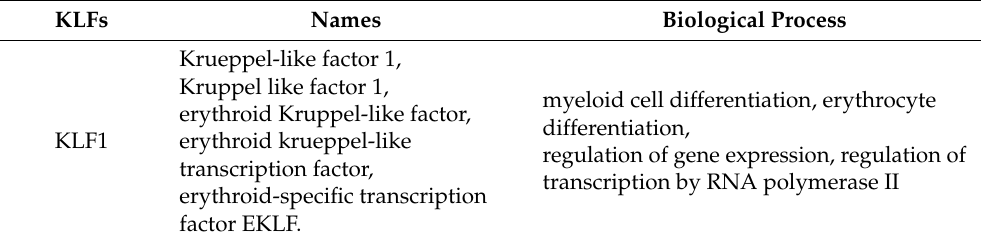
Table 1. Participation of Kruppel-like factors in various biological processes.